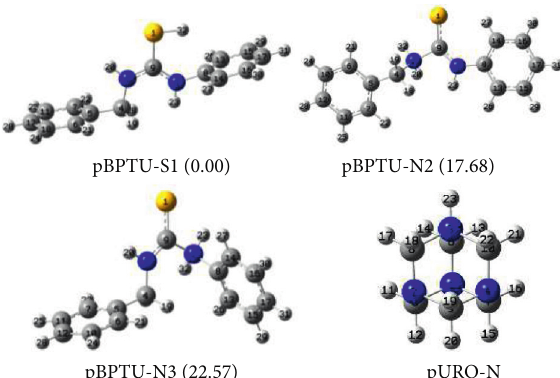
Figure 16: Optimized structures of protonated BPTU (pBPTU) and URO (pURO) (relative energies of protonated inhibitors comparing to the energy of pBPTU-S1 are shown in parentheses in kcal.mol − 1